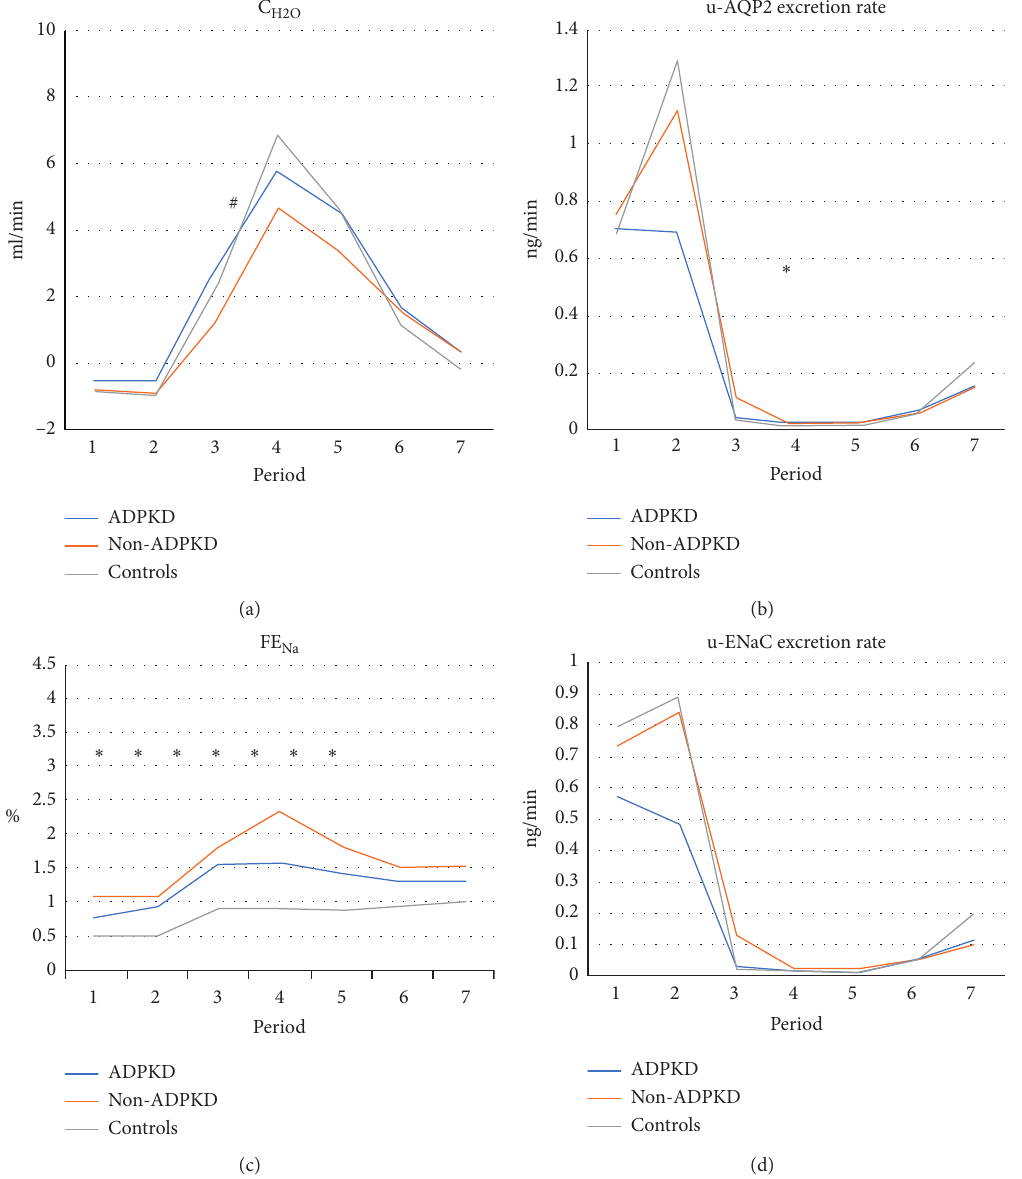
Figure 1: CH2O (a), u-AQP2 excretion rate (b), FENa (c), and u-ENaC excritoin rate (d) during urine dilution test in patients with adult dominant polycystic kidney disease (ADPKD), patients with non-ADPKD kidney disease (non-ADPKD), and healthy control subjects (controls). An oral water load of 20ml/body weight was given immediately after Period 2. Urine was collected in seven periods. Period 1 (24 hours): from 07.30 AM the day before arrival to the laboratory to 07.30 AM on the examination day. Period 2 (one hour): 07.30–08.30 AM. Period 3 (one hour): 08.30–09.30 AM. Period 4 (one hour): 09.30–11.30 AM. Period 5 (one hour): 10.30–11.30 AM. Period 6 (one hour): 11.30–00.30 PM. Period 7 (on hour): 00.30–01.30 PM. Values represent mean. # p < 0 . 005 between ADPKD and Non-ADPKD patients. (a). Values represent median ∗ p < 0 . 005 between ADPKD and/or non-ADPKD patients and healthy controls (b). Values represent mean. ∗ p < 0 . 005 between ADPKD and/or non-ADPKD patients and healthy controls (c). Values represent median ∗ p < 0 . 005 between ADPKD and/or non-ADPKD patients and healthy controls